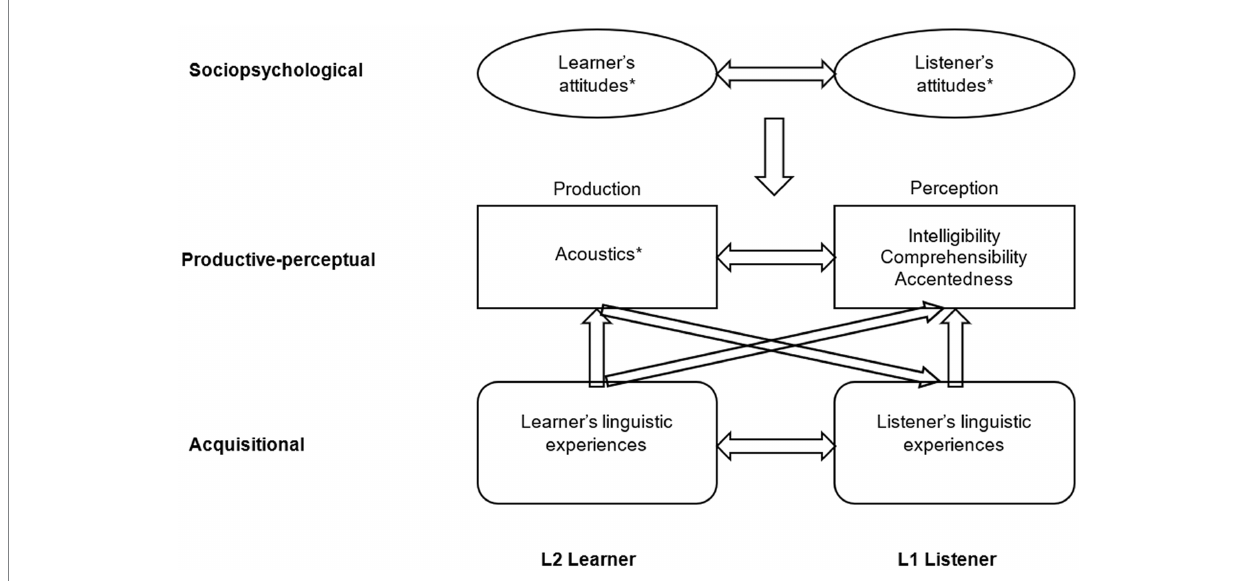
FIGURE 1 A three-layer conceptual model of L2 speech in communicative contexts. * The factor listed is only an example of the multidimensional information in the